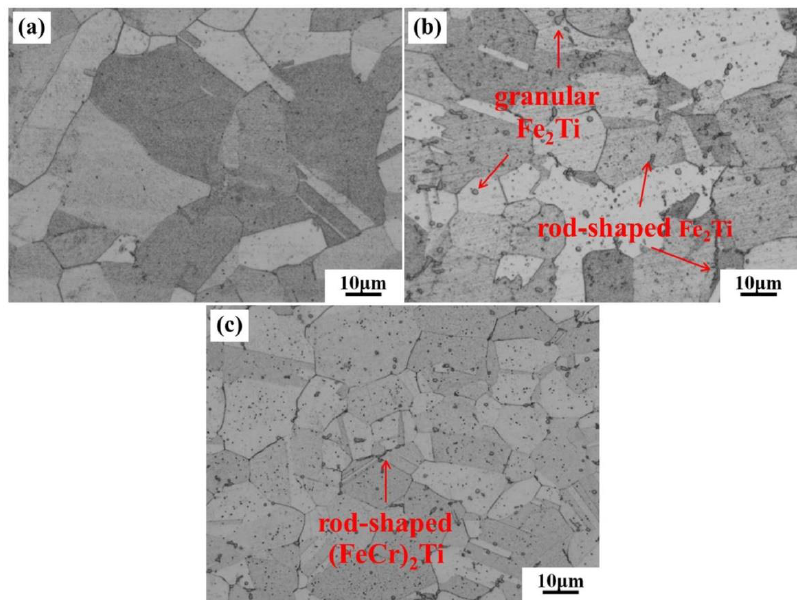
Figure 1 . Optical micrographs of the solution-treated specimens, at 900 °C, for 4 h. ( a ) Cu-3Ti; ( b ) Cu- Figure 1. Optical micrographs of the solution-treated specimens, at 900 ◦ C, for 4 h. ( a ) Cu-3Ti; Ti-Fe; and ( c ) Cu-Ti-Fe-Cr. ( b ) Cu-Ti-Fe; and ( c ) Cu-Ti-Fe-Cr.